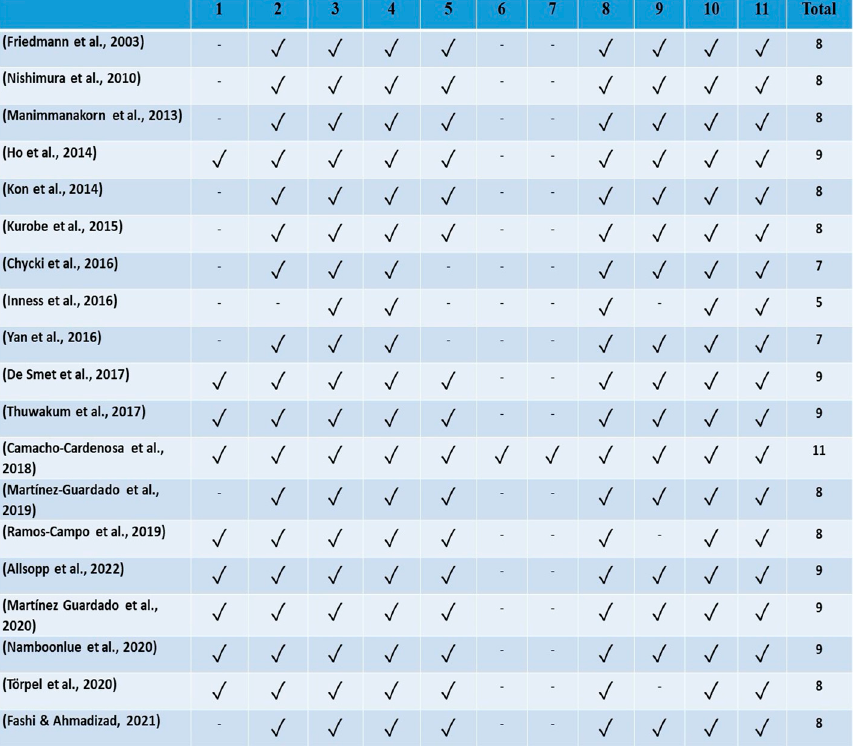
Figure 2. Methodological classification of studies used in the systematic review. A rating of 9–11 is considered excellent, a rating of 6–8 is good, a rating of 4–5 is acceptable, and a rating of ≤ 3 shows a lack of methodological quality [6,15–32].